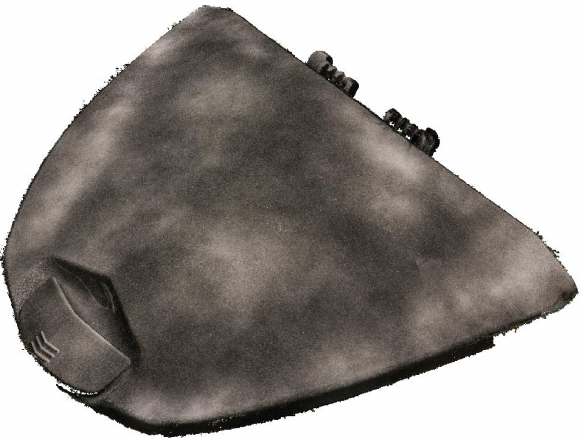
Figure 4: The completed dense point cloud from the photogrammet- ric